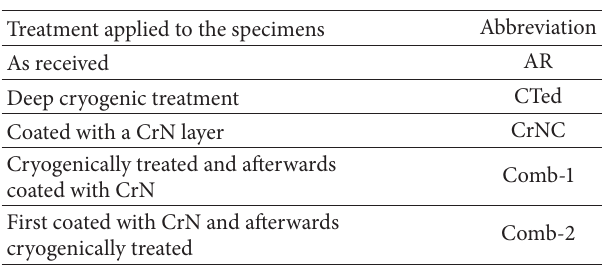
Table 2: Specimens